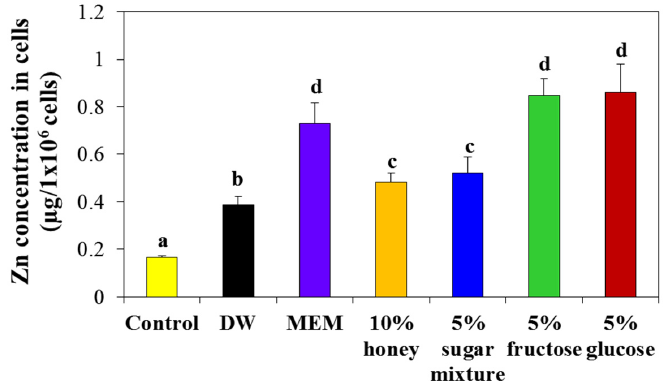
Figure 9. Cellular uptake of ZnO NPs in DW, MEM, or different saccharide solutions in Caco-2 cells after incubation for 6 h, as determined by inductively coupled plasma-atomic emission spectroscopy (ICP-AES). Different lower-case letters (a–d) indicate significant differences among DW, MEM and different saccharide solutions ( p < 0.05).